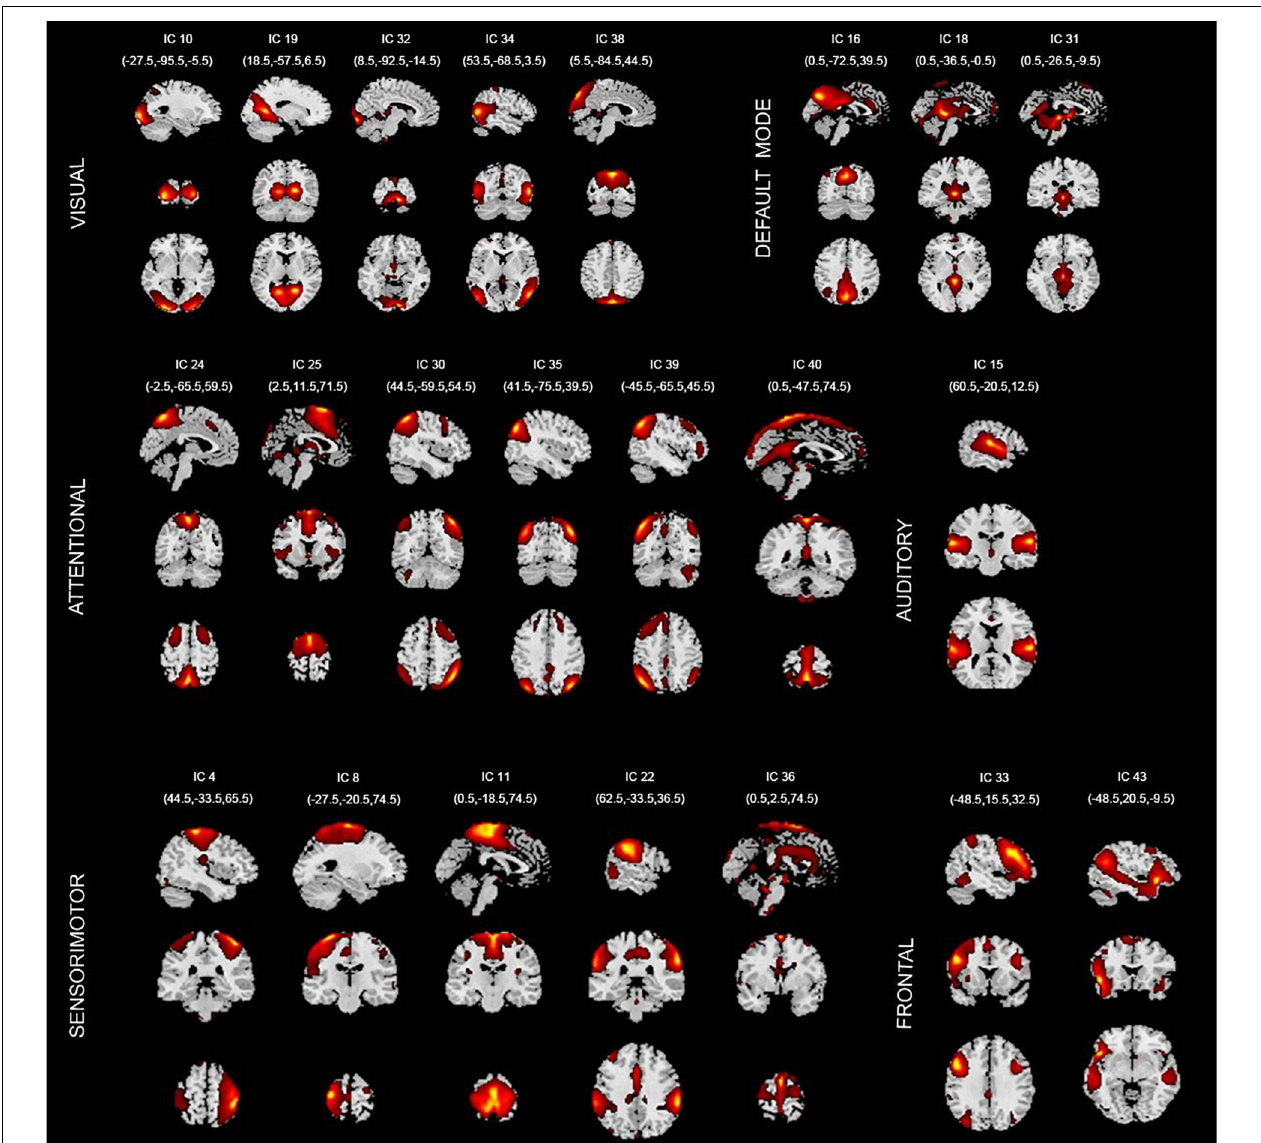
FIGURE 3 | Spatial maps of the 22 components identified as intrinsic connection network (ICNs). VISUAL, visual network; DEFAULT MODE, default mode network; ATTENTIONAL, attentional network; AUDITORY, auditory network; SENSORIMOTOR, sensorimotor network; FRONTAL, frontal network. IC, independent